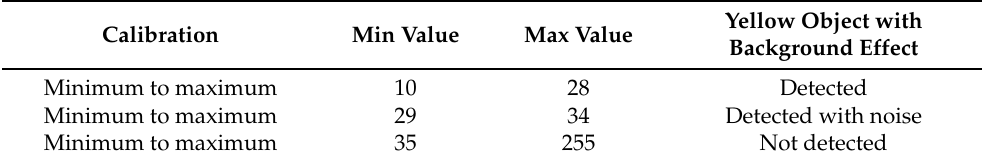
Table 1. The result of the hue calibration phase.